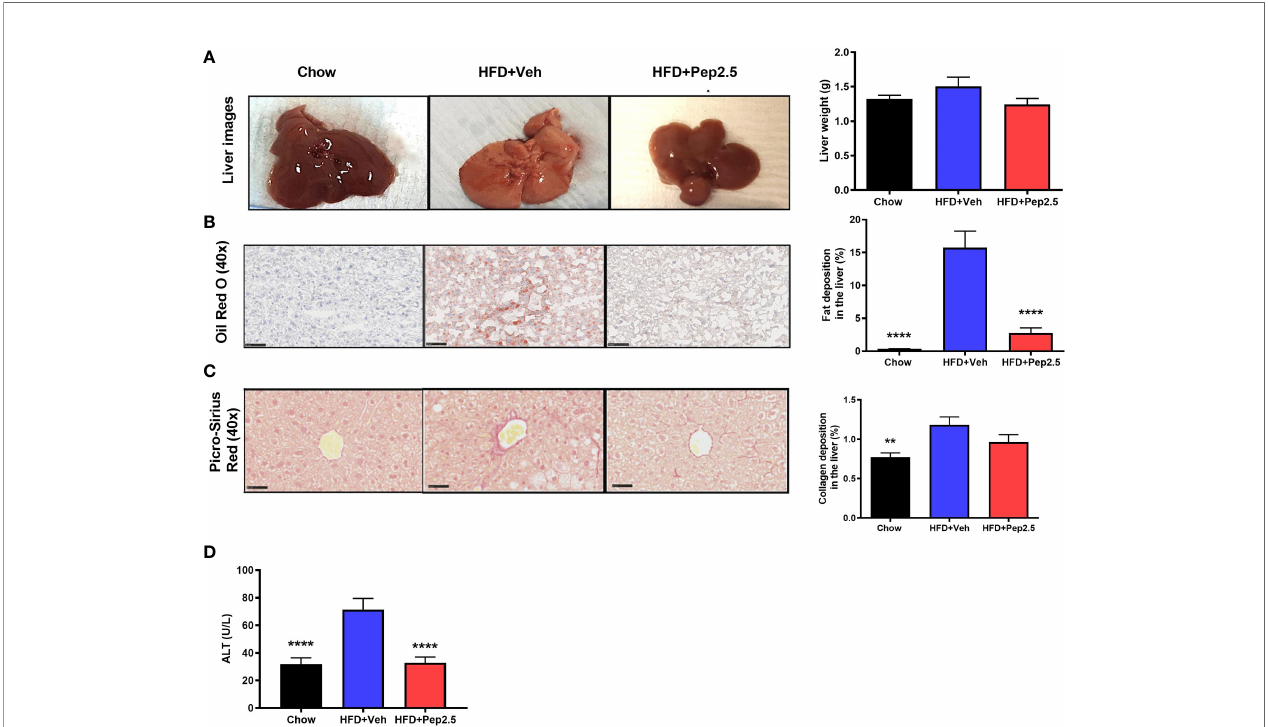
FIGURE 5 | Peptide 19-2.5 abolishes steatohepatitis in HFD-fed mice. (A) Liver images of mice immediately after being culled and the liver weights (g). (B) Images of hepatic lipid deposition using Oil Red O staining and quanti fi ed as percentage of fat deposition (%). (C) Images of hepatic collagen deposition using Picro-Sirius Red stain to quantify percentage collagen deposition (%). Insert images are 40x magni fi cation digital zoom and scale bars measure 50µm. (D) Serum ALT (U/L). Data were analyzed by one-way ANOVA, with Bonferroni ’ s post-hoc test. Data are expressed as mean ± SEM; n = 20 per group. **P < 0.01 and ****P < 0.0001 vs.